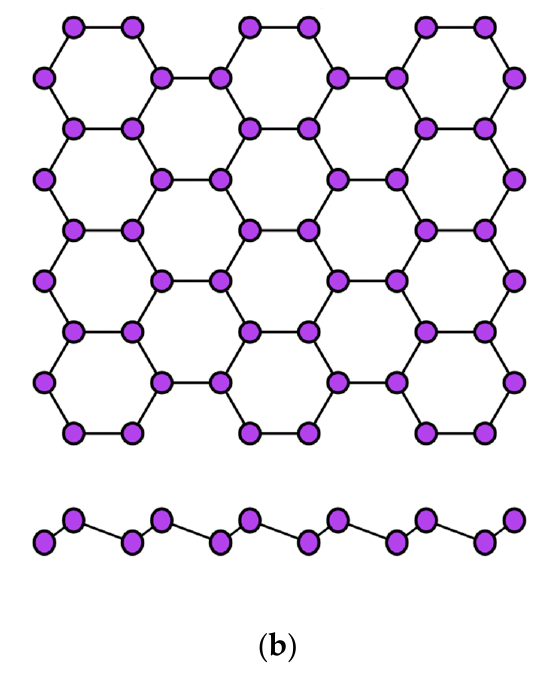
Figure 4. Two variants of the crystal structure of phosphorene: ( a ) puckered ( α -phase) and ( b ) buckled ( β -phase). Table 2. Parameters of the honeycomb lattice of group IIIA transgraphenes (materials predicted only theoretically and not obtained experimentally are marked with *